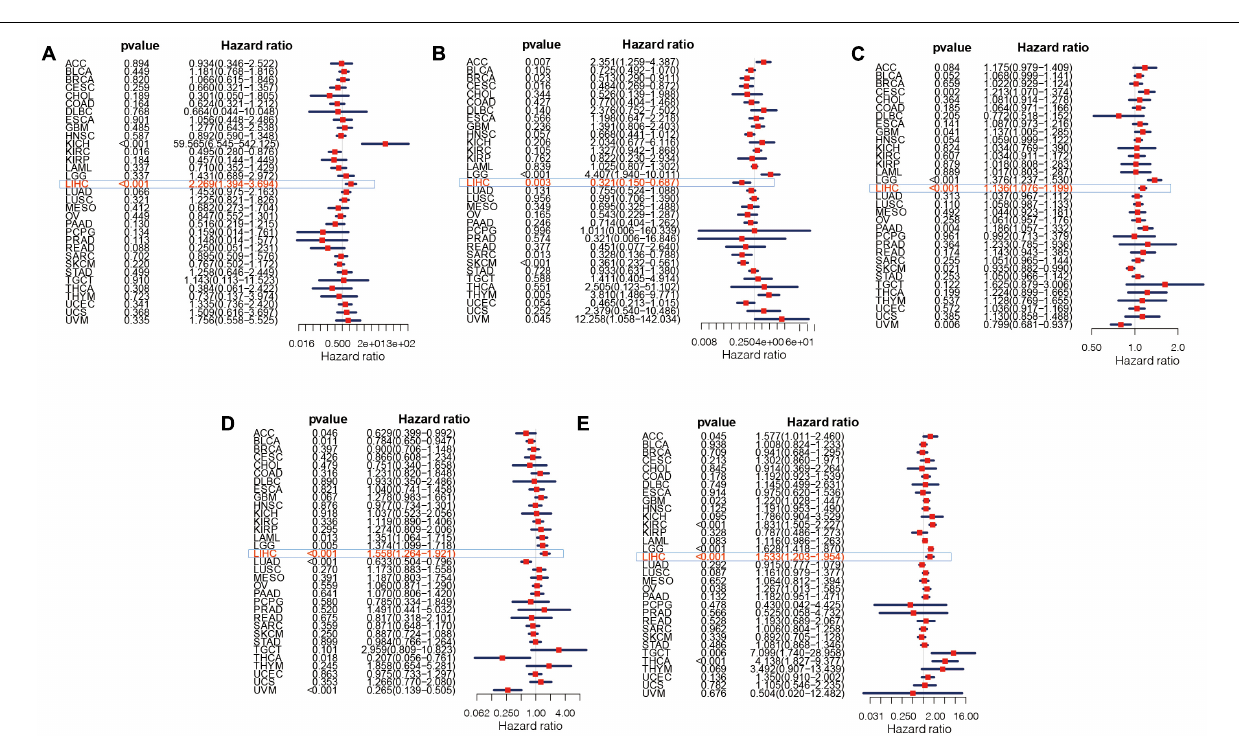
of SPP1 in HCC suggests a poor prognosis (Chen et